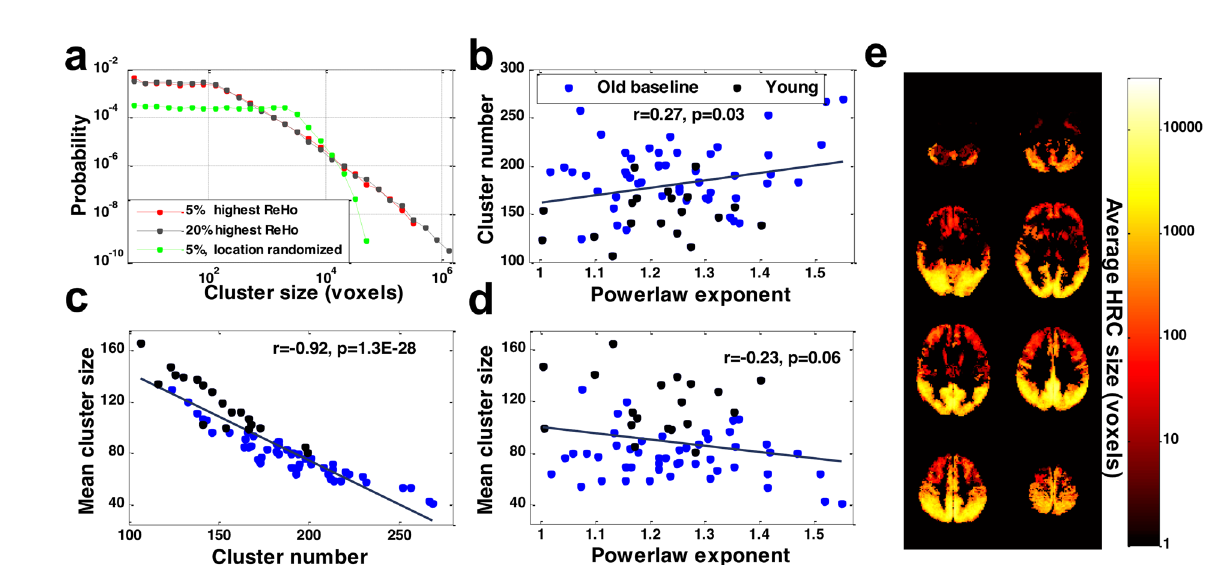
Figure 2. The quantitative profile of HRCs. ( a ) The size distribution of HRCs at the group level (all the older participants at baseline). HRCs were extracted with two different thresholds (5% and 20% highest ReHo voxels) and with the anatomic constraint of grey matter. The size distribution lost its power-law property when ReHo images were randomized (green line). ( b – d ) The relationships between cluster number, mean cluster size, and the power law exponent of the HRC size distribution (black dots: younger participants; light blue dots: older participants at baseline). ( e ) The average HRC size in space. The HRCs in ( b – e ) were composed of the highest 10% ReHo voxels for each participant and were constrained by grey matter